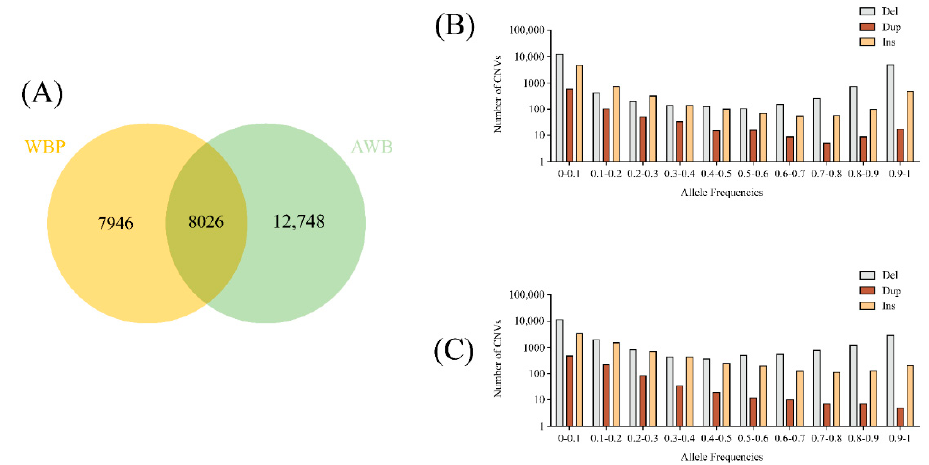
Figure 1. ( A )The Venn diagram of CNVs between WBP and AWB. ( B ) The allele frequencies of variants in the WBP ( n = 45). ( C ) The allele frequencies of variants in the AWB ( n = 19). Table 2. Annotation of the merged CNVs.